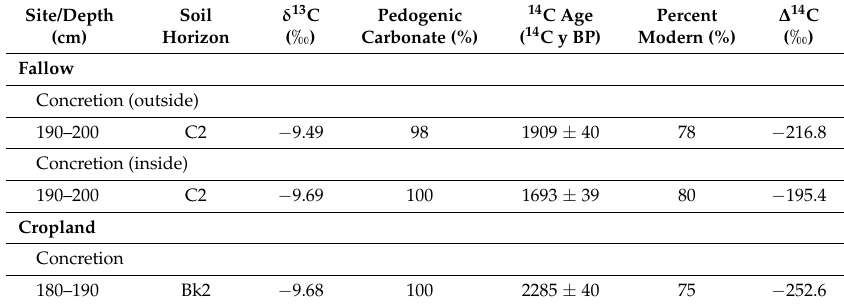
Table 7. Soil concretions’ 14 C date, y BP with depth and site (sampling date: 1997; year of 14 C measurements: